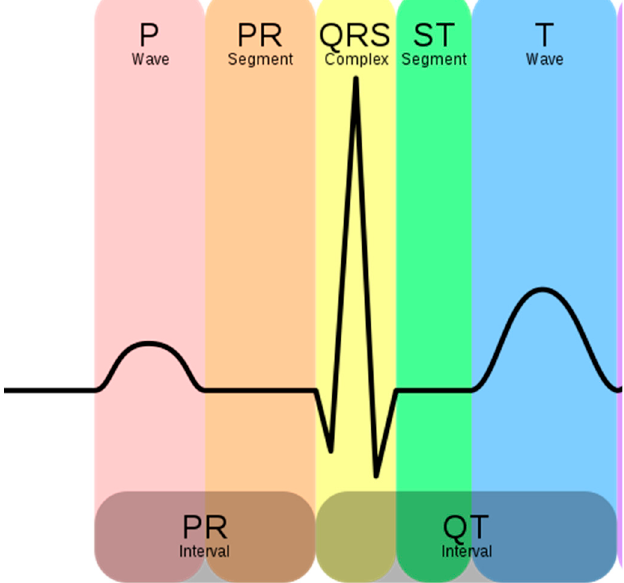
Figure 3. Schematic representation of a normal electrocardiogram (ECG). P, Q, R, S, T are graphical deflections of a typical electrocardiogram. They express depolarization and repolarization of the human heart.